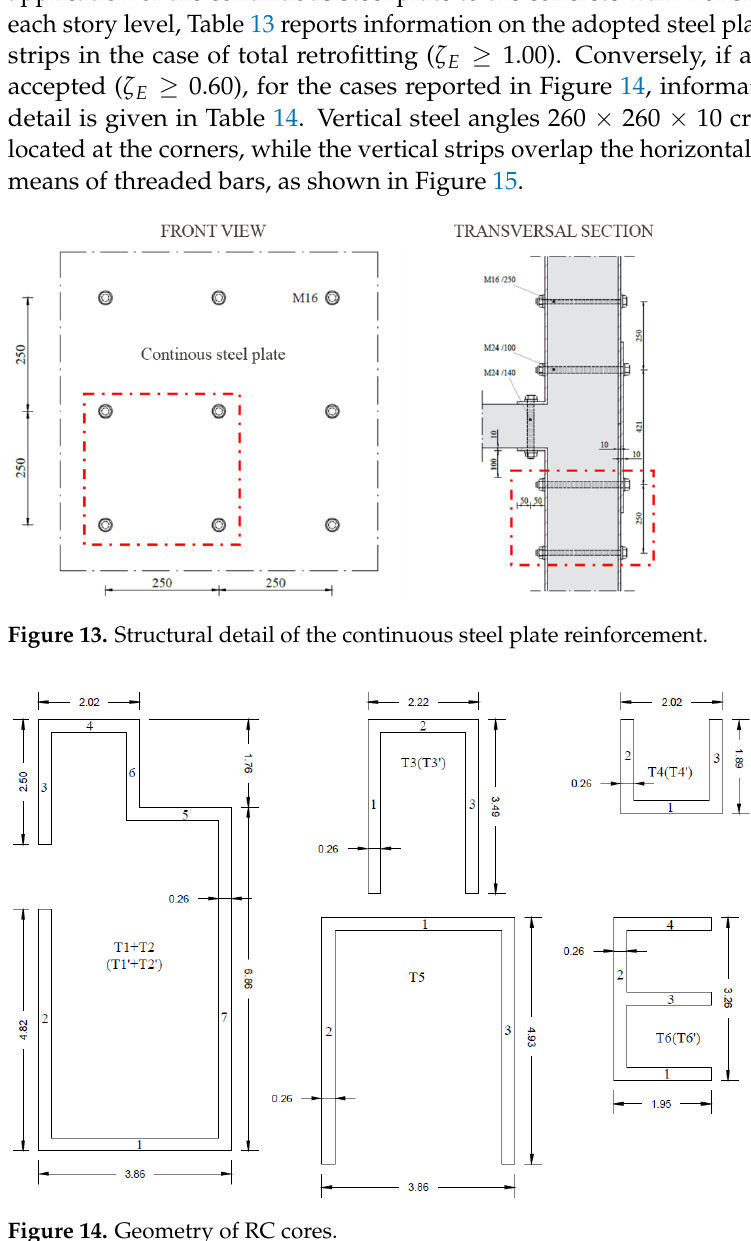
Figure 15. Structural detail of the horizontal steel strips applied to the concrete wall. Legend: 1)